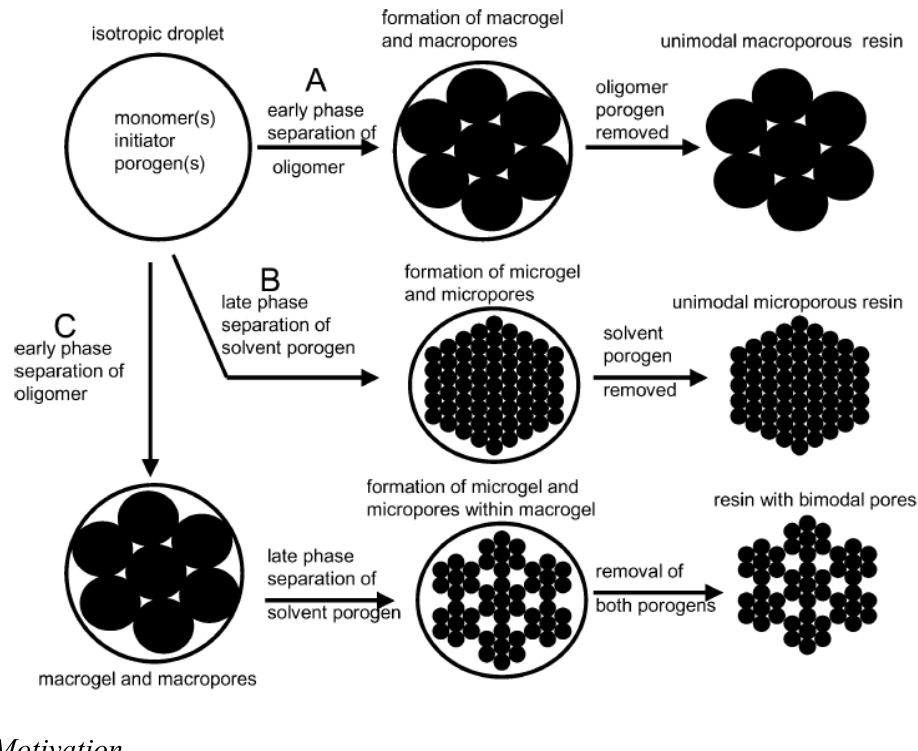
Figure 1. Schematic representation of pore formation in poly(DVB) resins: ( A ) using a “bad” solvent porogen; ( B ) using a thermodynamically “good” solvent porogen; and ( C ) using a mixture of “good” and “bad” solvent porogen as co-porogens. (Reprinted (adapted) with permission from [18]. Copyright 2004 American Chemical Society). NB: The pores are of different sizes and are not drawn according to scale, as shown